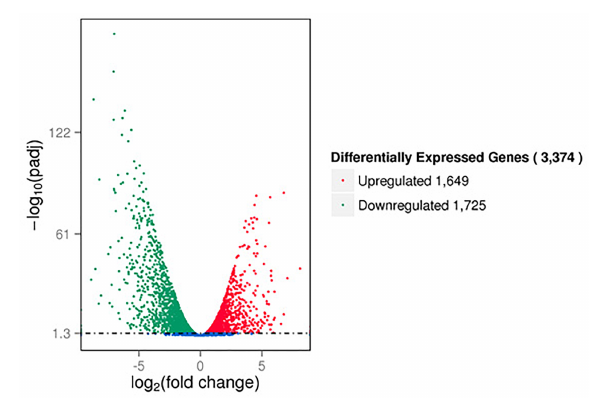
aeruginosa PAO1. Each gene is represented by a dot in the graph. The x -axis and y -axis represent the log 2 value of the fold change and the t-statistic as –log 10 of the p -value, respectively. The genes represented in red (upregulated) and green (downregulated) are differentially expressed genes with > twofold change and a p -value <